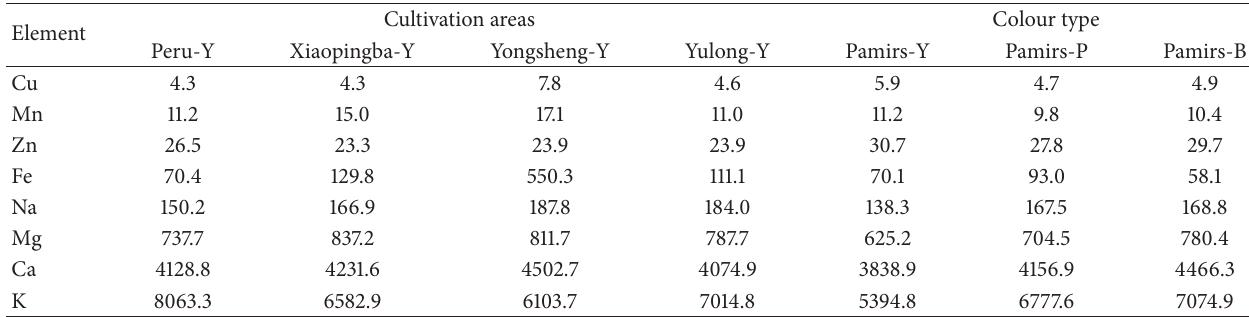
Table 4: Mineral contents (mg/kg DM) in maca samples of different cultivation areas and colour types. Cultivation areas Colour type Element